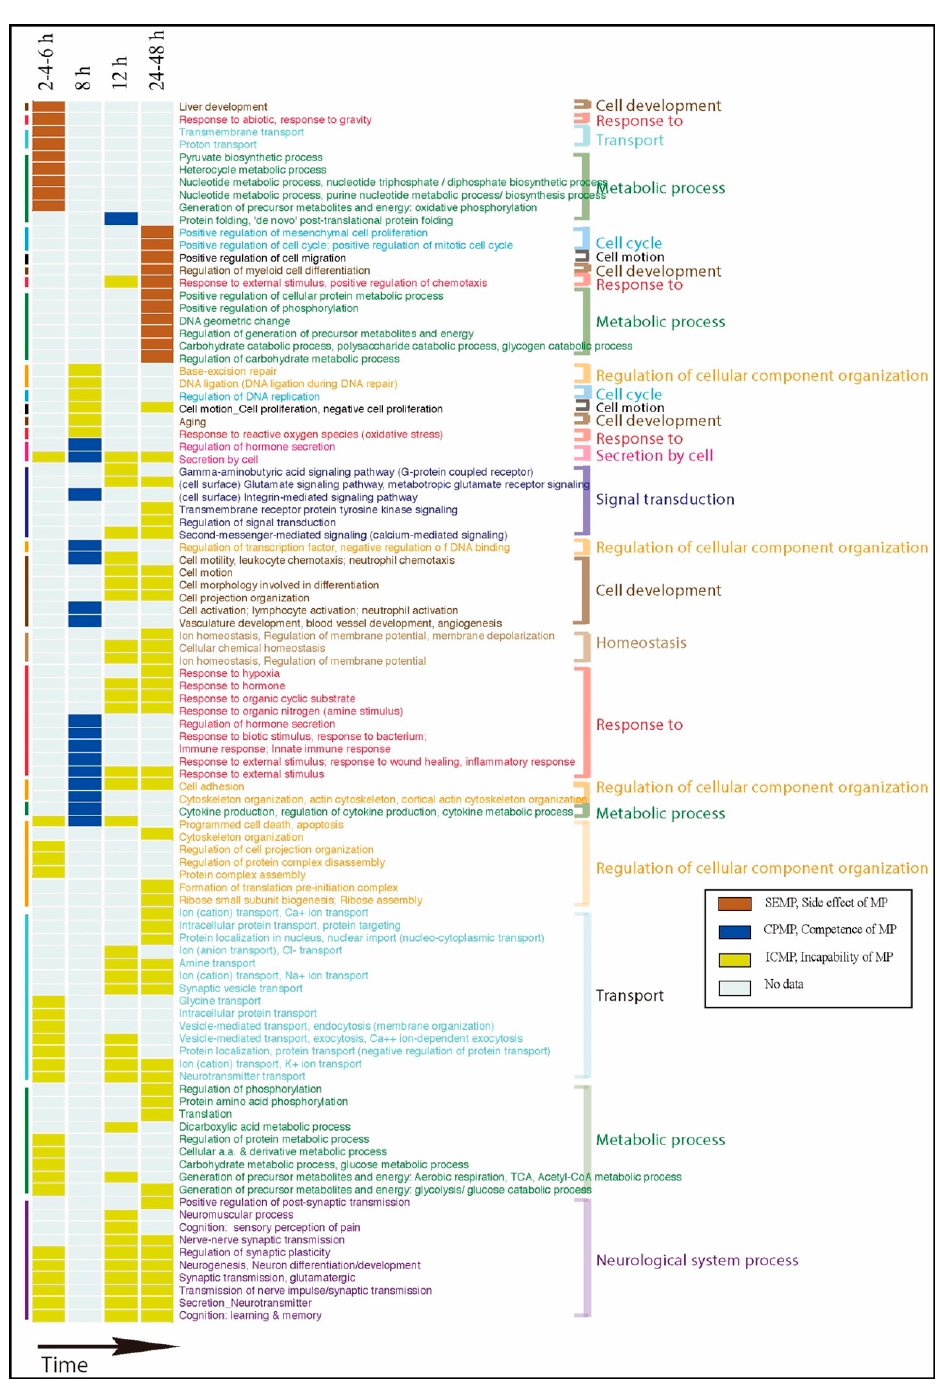
Figure 4. Visualization of the associated biological process of three gene classes in a time series fashion. The colors of each gene class are as